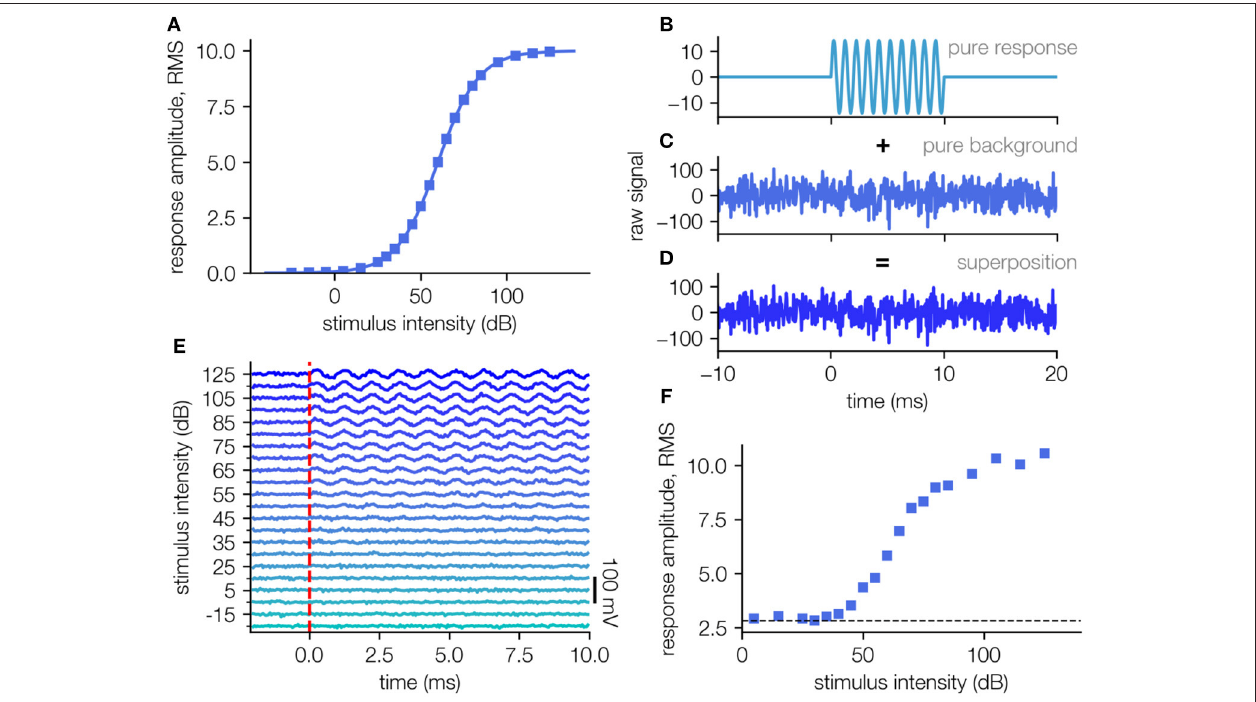
FIGURE 1 | Generation of artificial test data sets. (A) Template amplitude response function used to generate the artificial field potential. (B) The stimulus response is simulated as a sine-wave of frequency 1,000Hz and a duration of 10ms (impulse response to short stimulus). (C) The measurement noise is modeled as Gaussian white noise with an RMS amplitude 4 times higher than the maximal simulated response. (D) The artificial signal is a superposition of the simulated response and the simulated background noise. (E) Simulated neuronal signal (e.g., ABR waves superposed with background noise), each averaging 200 single trials (D) . (F) Response intensity function for the simulated data set in (E) . The RMS of the background alone (dashed line) is 40 √ 200 being ∼